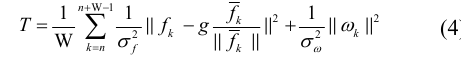
Figure 2. The experimental facility